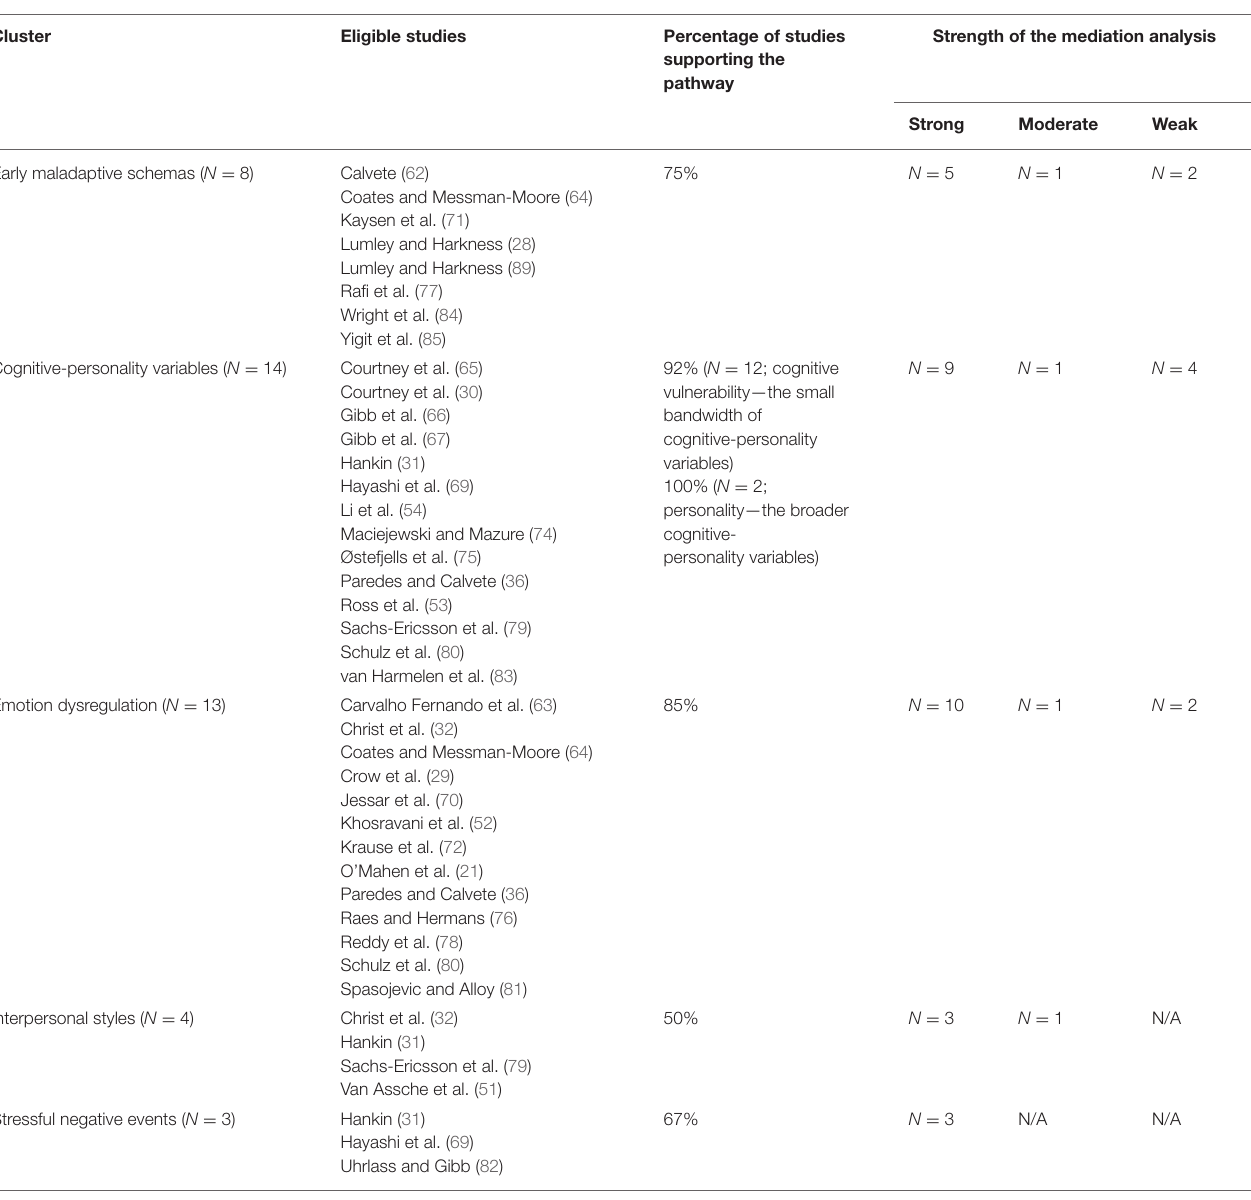
TABLE 3 | Summary of results and mediational analytic approaches. Cluster Eligible studies Percentage of studies